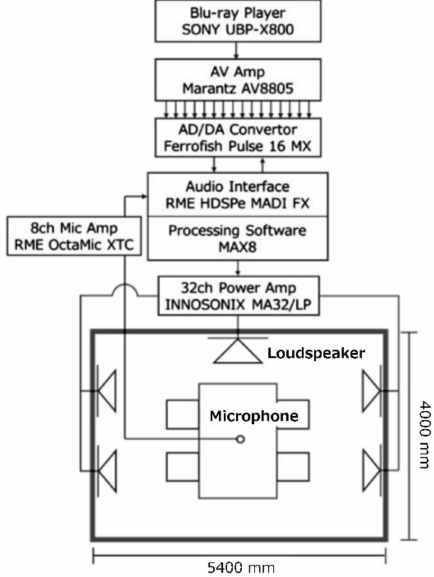
Figure 1. Diagram of the acoustic system used in this